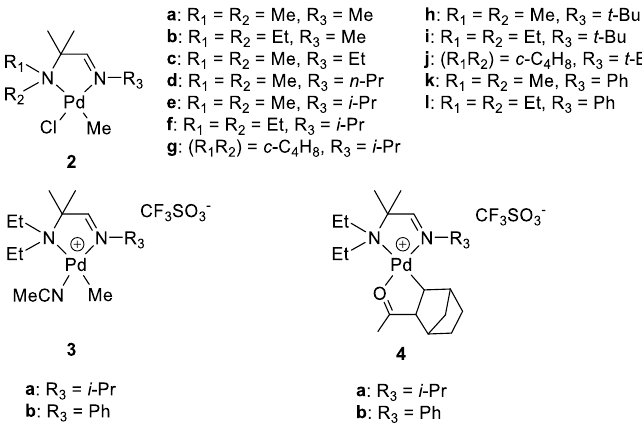
Figure 3. Amine – imine palladium complexes with different substituents.